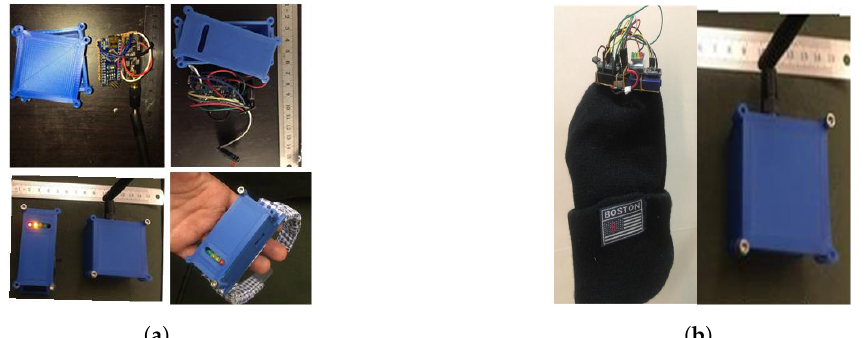
Figure 5. HeadUp system (transmitter and receiver). ( a ) HeadUp for moderate CP. ( b ) HeadUp for severe CP.